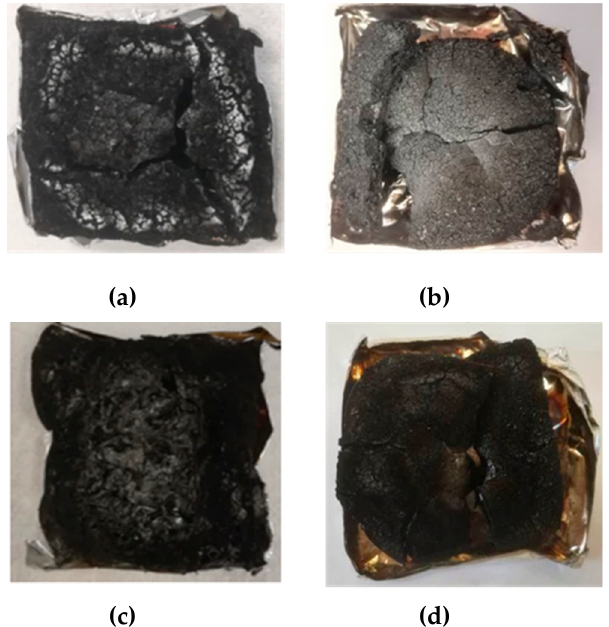
Figure 6. Photographs of the char residues obtained after cone calorimetry tests for ( a ) DGEBA / MNA, ( b ) BOMF / MNA, ( c )DGEBA / MNA_2Si and ( d ) BOMF / MNA_2Si.